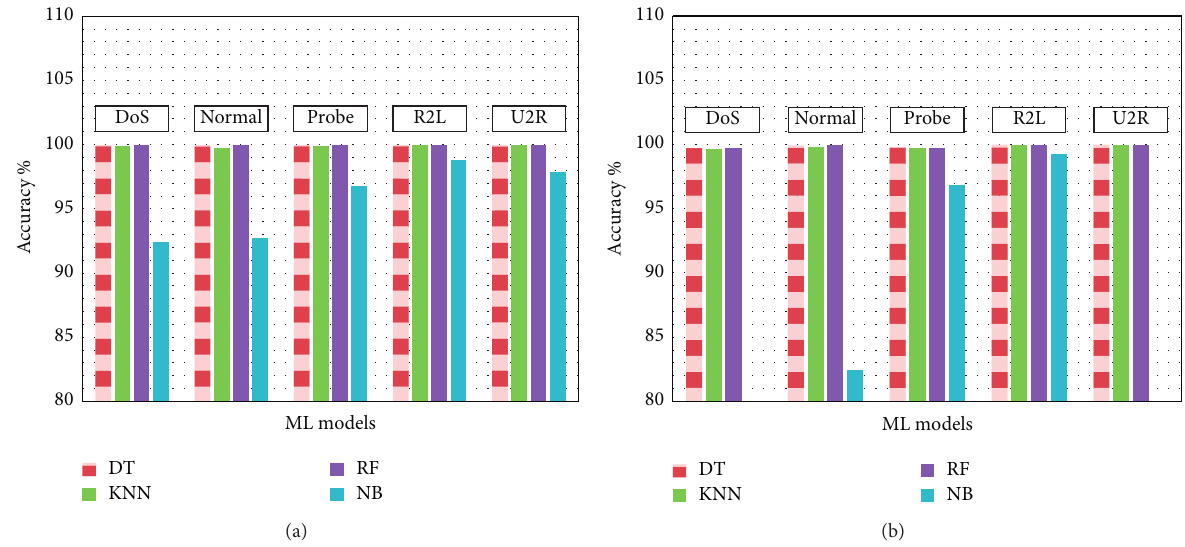
Figure 5: The results of machine learning cross-validation performance for KDD dataset: (a) accuracy using all features and (b) accuracy using selected